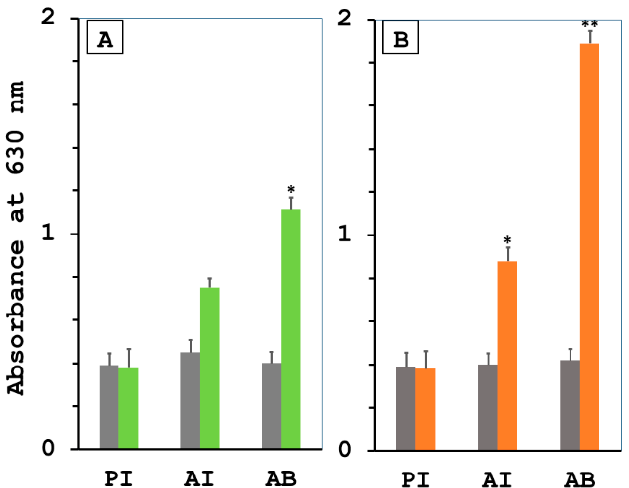
Figure 1. Induction of the specific humoral immune responses in hamsters immunized with LRR proteins, either the rKU_Sej_LRR_2012M or the rhKU_Sej_LRR_2271. ( A ) rKU_Sej_LRR_2012M- specific IgG and ( B ) rhKU_Sej_LRR_2271-specific IgG were evaluated in experiment 1 by ELISA. The level of specific IgG production shown on the Y-axis was compared between the control (gray bar) and the immunized hamsters with each protein (green bar: rKU_Sej_LRR_2012M; orange bar: rhKU_Sej_LRR_2271). Sera from the control and immunized hamsters were collected on day 0 (pre-immunization, PI), day 21 (3 weeks after the 1st immunization, AI), day 42 (3 weeks after the 2nd immunization or after 1st boost, AB) as shown on X-axis. The data represent the mean of eight hamsters per treatment group ± S.E.M. The * and ** indicate significant differences in p -values < 0.05 and <0.01,